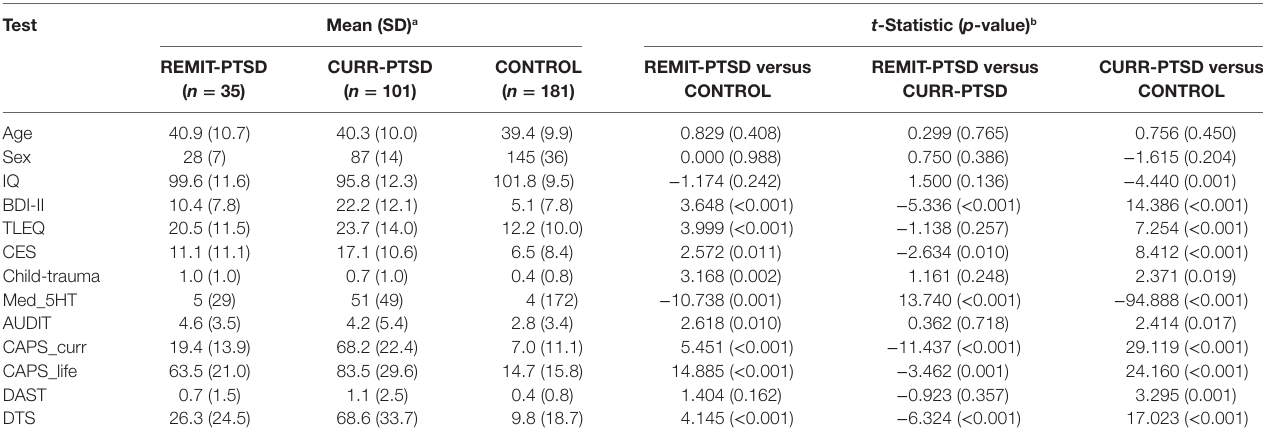
TaBle 1 | Demographic